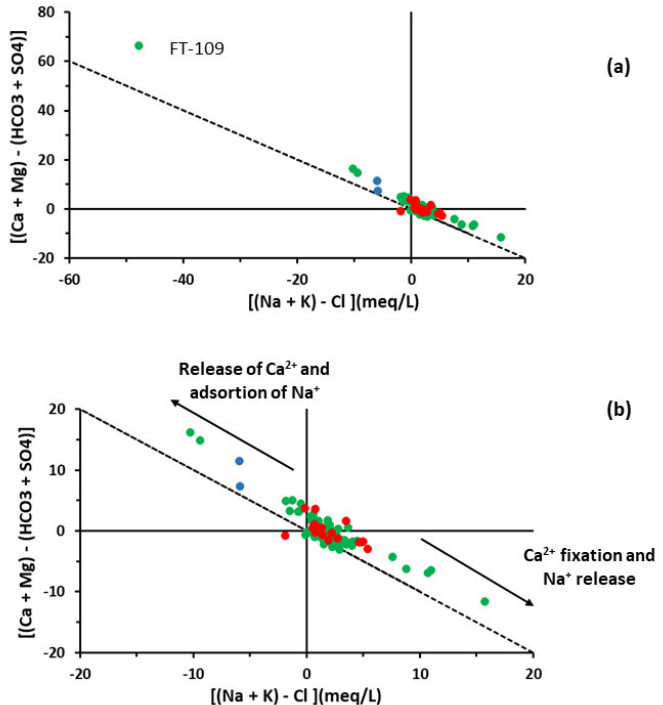
Figure 4. ( a ) Na + vs. Cl − content; ( b ) Na + vs. Cl − content without FT-109; ( c ) Ca 2+ vs. HCO 3 − ( d ) Ca 2+ Figure 7. ( a ) [(Ca 2+ + Mg 2+ ) - (HCO 3- + SO 42- )] vs. [(Na + + K + ) - Cl - ]; ( b ) [(Ca 2+ + Mg 2+ ) - (HCO 3- + SO 42 )] Figure 3. Piper diagram for Santiago Island groundwater samples. The symbols stand for: (  ) base Figure 3. Piper diagram for Santiago Island groundwater samples. The symbols stand for: (  ) base vs. HCO 3 − without FT-109. The symbols stand for: (  ) base unit formation; (  ) middle unit for- vs. [(Na + + K + ) - Cl - ] without the water sample FT-109. The symbols stand for: (  ) base unit for- unit formation; (  ) middle unit formation; (  ) recent unit formation. unit formation; (  ) middle unit formation; (  ) recent unit formation. mation; (  ) recent unit mation; (  ) middle unit formation; (  ) recent unit formation.